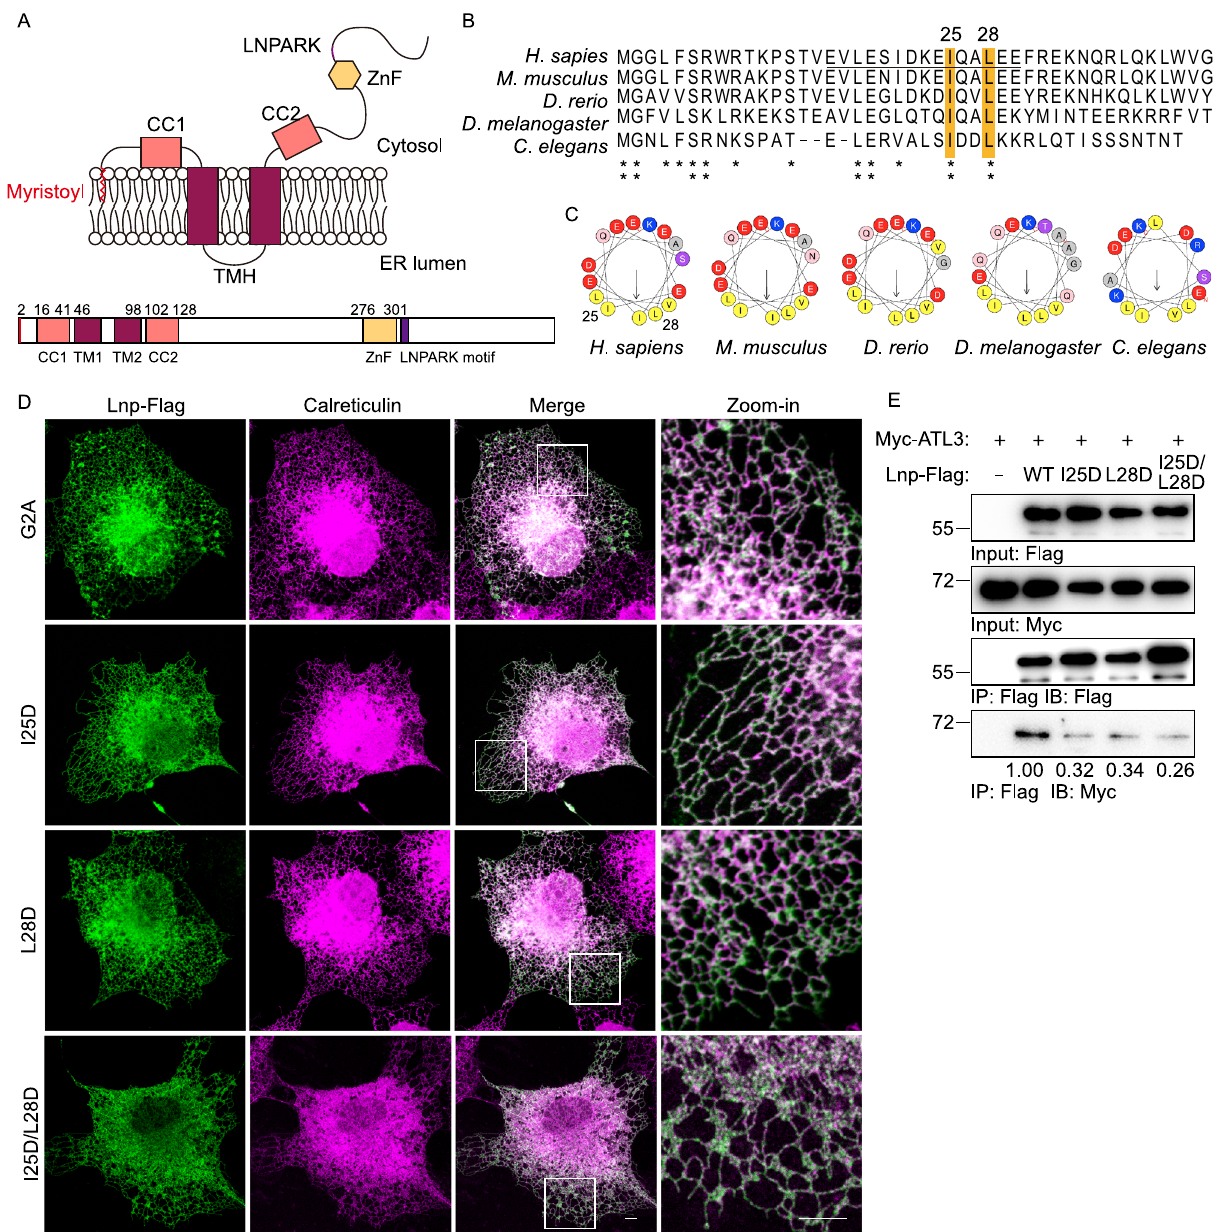
Figure 2. Lnp-NTregulates the localization of Lnp. (A) Topology and schematic of the secondary structure of Lnp. CC1, coiled coil 1; TMH, transmembrane hairpin; CC2, coiled coil 2; ZnF, zinc fi nger. (B) Sequence alignment of Lnp-NT from the indicated species. The amphipathic helix is underlined. Conserved hydrophobic residues I25 and L28 (order number in human Lnp) are highlighted in yellow. *, similar residues; **, identical residues. (C) Helical wheel representation of the underlined sequence in (B) generated using HeliQuest. (D) The indicated mutants of Lnp were expressed in COS-7 cells. Their localization was determined by anti-Flag antibodies (green). The ER was visualized by antibody against ER luminal marker calreticulin (magenta). Scale bars = 5 μ m. (E) Interaction tests between Myc-tagged ATL3 and various Flag-tagged LNP mutants by co-immunoprecipitation. Myc-ATL3 was expressed individually (lane 1) or together with Flag-tagged wild-type LNP (lane 2) or the indicated mutants (lanes 3 to 5). Various Lnp-Flag proteins were precipitated from the cell lysates containing 1% Triton X-100 by anti-Flag antibody-conjugated agarose and immunoblotted with anti-Flag and anti-Myc antibodies. Quanti fi cation of Co-IPed Myc-ATL3 was performed by Image